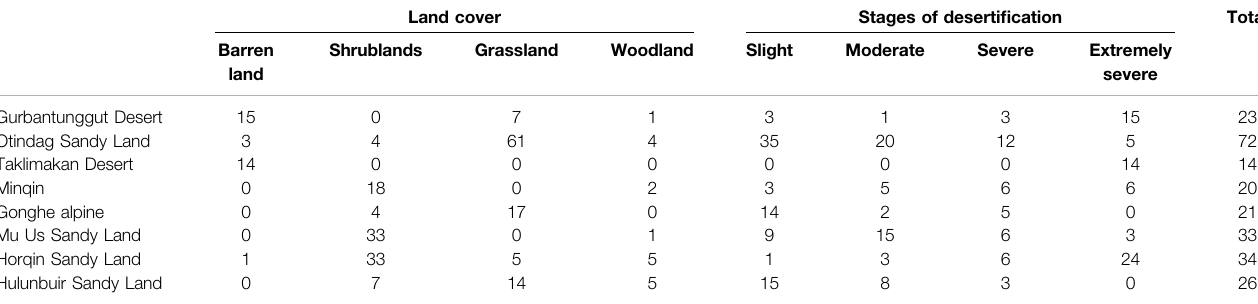
TABLE 1 | Distribution of sample